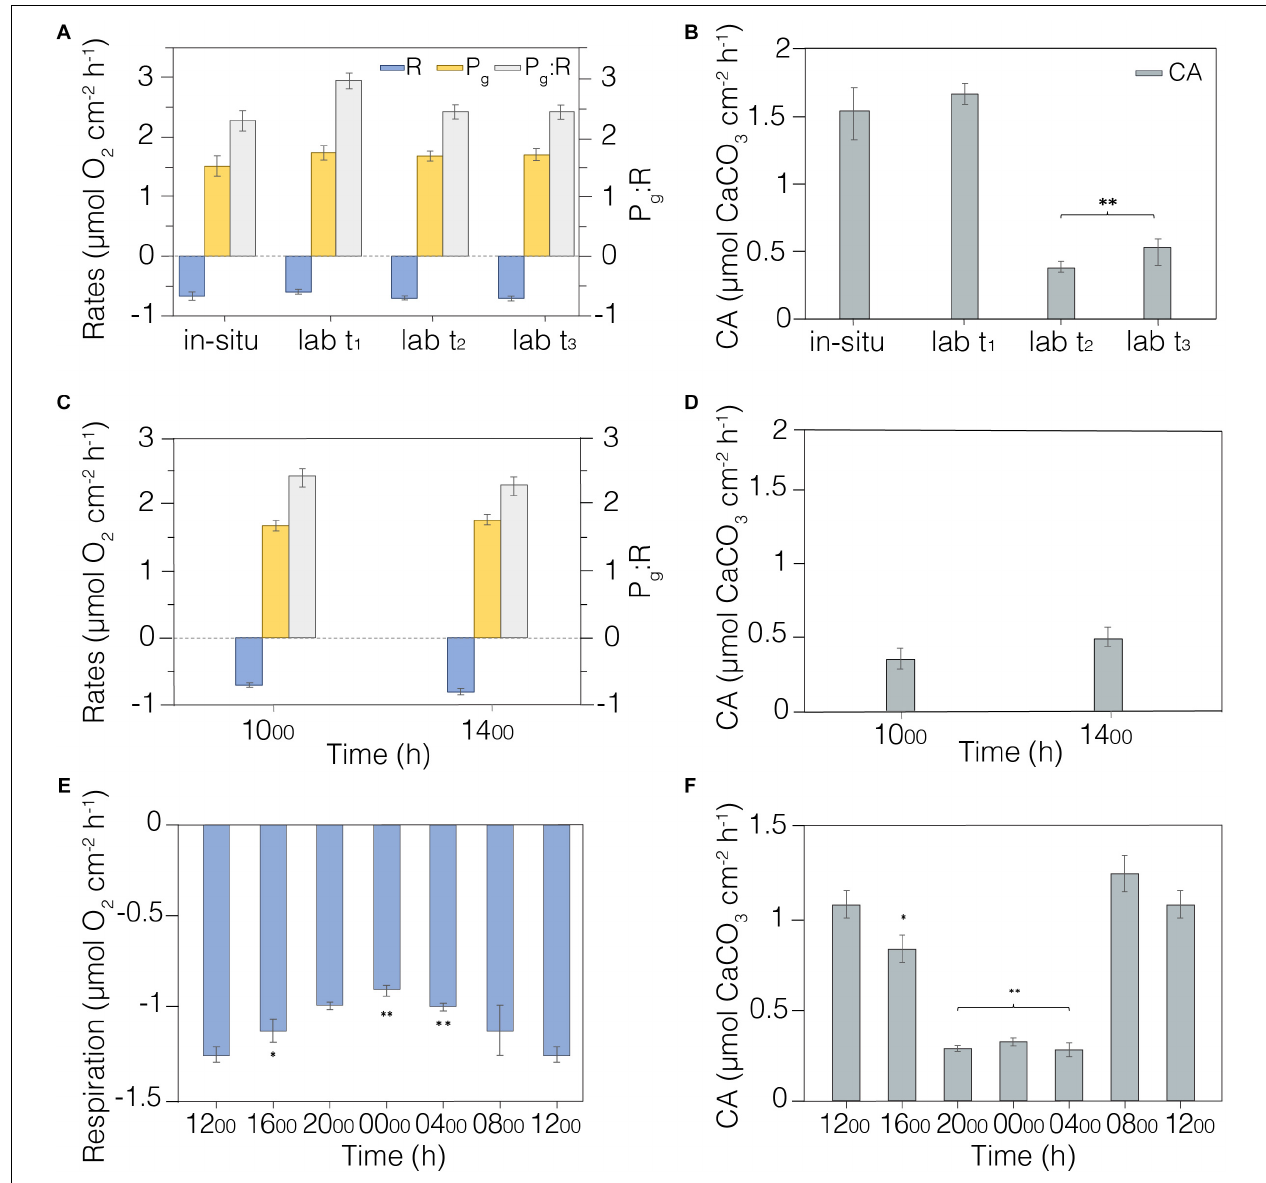
FIGURE 5 | Metabolic rates measured in laboratory conditions. (A) Field and laboratory comparison of metabolic rates (R, P g , and P g :R) measured in situ ( n = 6) and in laboratory-controlled conditions during the acclimation period ( n = 12). (B) Calcification rates measured in situ ( n = 6) and in laboratory acclimation tank ( n = 12). (C) Morning and afternoon metabolisms (R, P g , and P g :R) were verified during measurements at two time period ranges (1000–1300 h and 1400–1700 h; n = 12). (D) Calcification rates measured in morning (1000–1300 h) and afternoon (1400–1700 h); n = 12. (E) Diel coral respiration was investigated using measurements taken every four hours ( n = 4); values at 1200 h are the same. (F) Calcification rates measured every four hours ( n = 4); values at 1200 h are the same. Average and standard error shown. **Indicates significative differences p < 0.01; *indicates significative differences p < 0.05. The legend is shown in the first